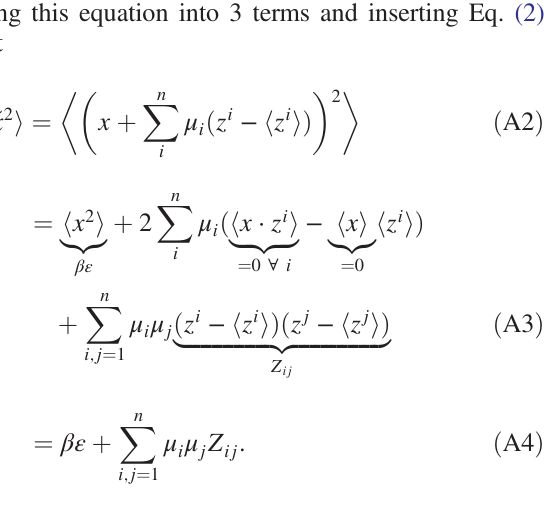
ffiffiffiffiffiffiffiffiffiffiffiffiffiffiffiffiffiffiffiffiffiffiffiffiffiffiffi p 1 þ M þ M (cid:2) □ ð A10 n n